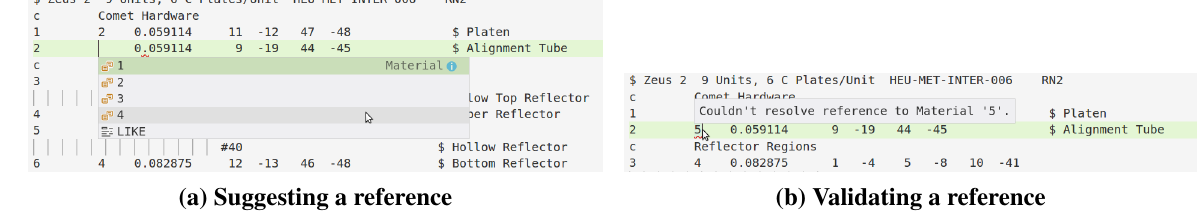
Figure 2: Reference resolving in the MCNP